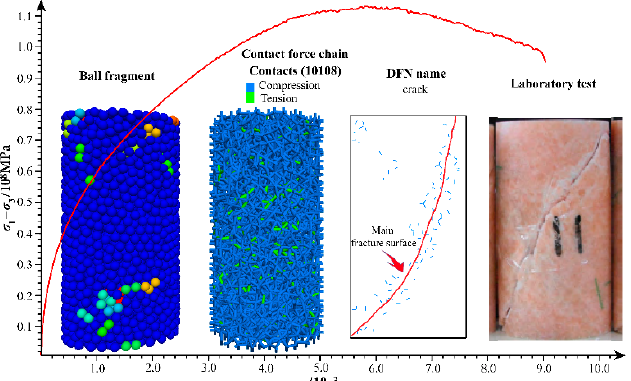
Figure 18. Results of numerical test and laboratory test.